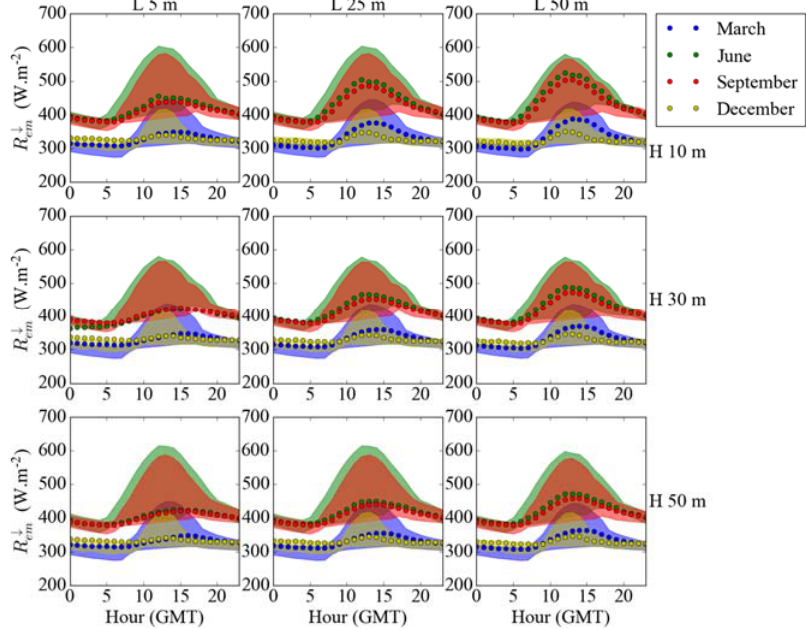
Figure 9. Hourly estimates of R ↓ em for four clear days: one in March (blue), one in June (green), one in September (red) and one in December (yellow) and for the nine canyon configurations. The dots represent R ↓ em estimated using the proposed method and the error areas are computed using the minimum and maximum LST values observed over the scene.